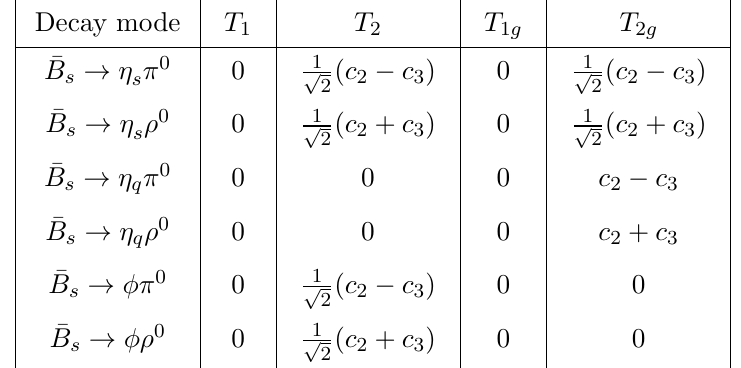
for (cid:22) B s ! ( (cid:17); (cid:17) 0 ; (cid:30) )( (cid:25) 0 ; (cid:26) 0 ) decays. The hard kernels T 1 ; 2 ; 1 g; 2 g , respectively, through the replacement c r;rg